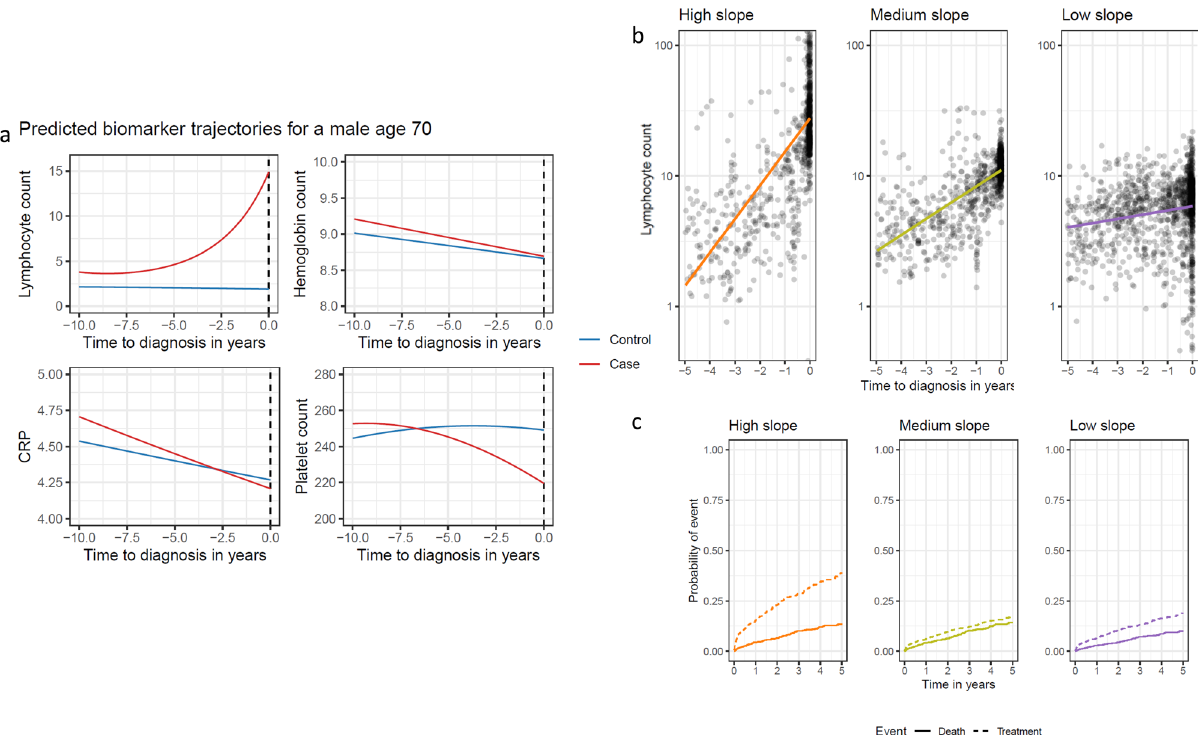
Fig. 2 Model predictions for a 70-year-old person. a Predictions for a 70-year-old male based on the linear regression model for absolute lymphocyte count (ALC), hemoglobin count, CRP, and platelet count. b Observed ALC for the three slope groups. The colored line is a linear smoother. c The graphs show the cumulative incidence of time to fi rst treatment or death from time of diagnosis for the three pre-diagnostic slope groups for a male with CLL-IPI 1.